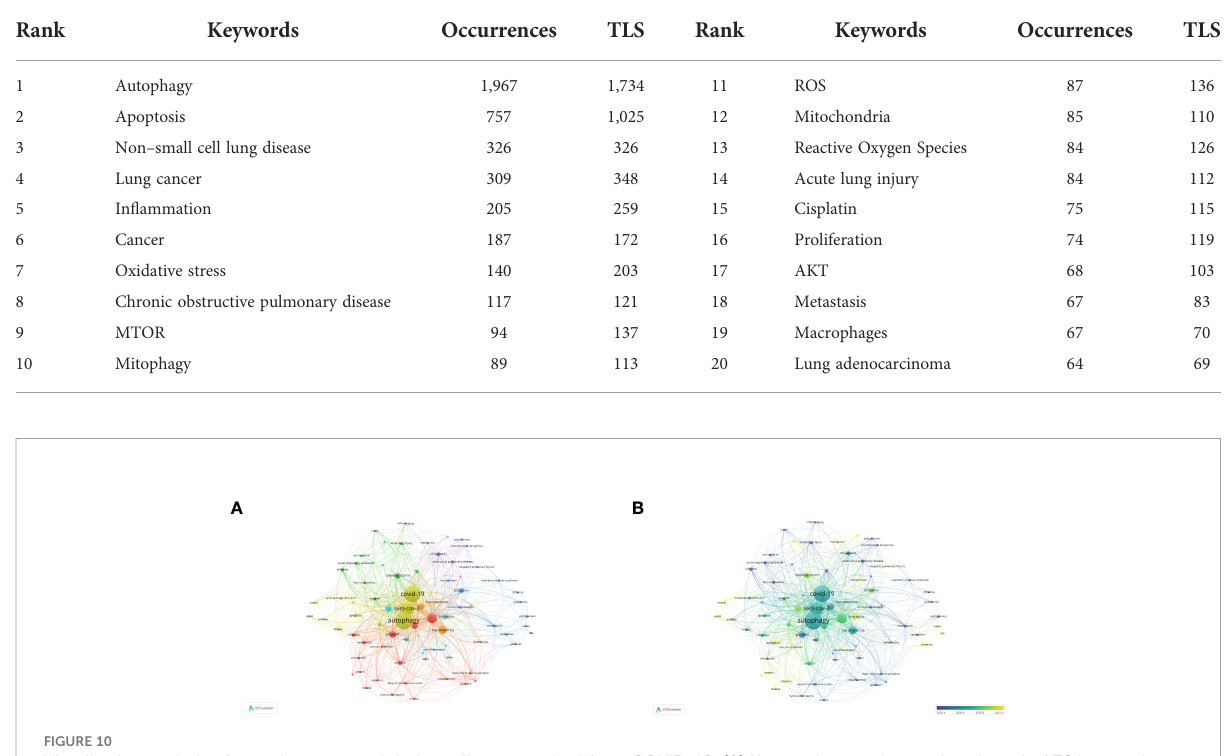
TABLE 6 Top 20 keywords of publications regarding autophagy research in lung disease based on occurrences.